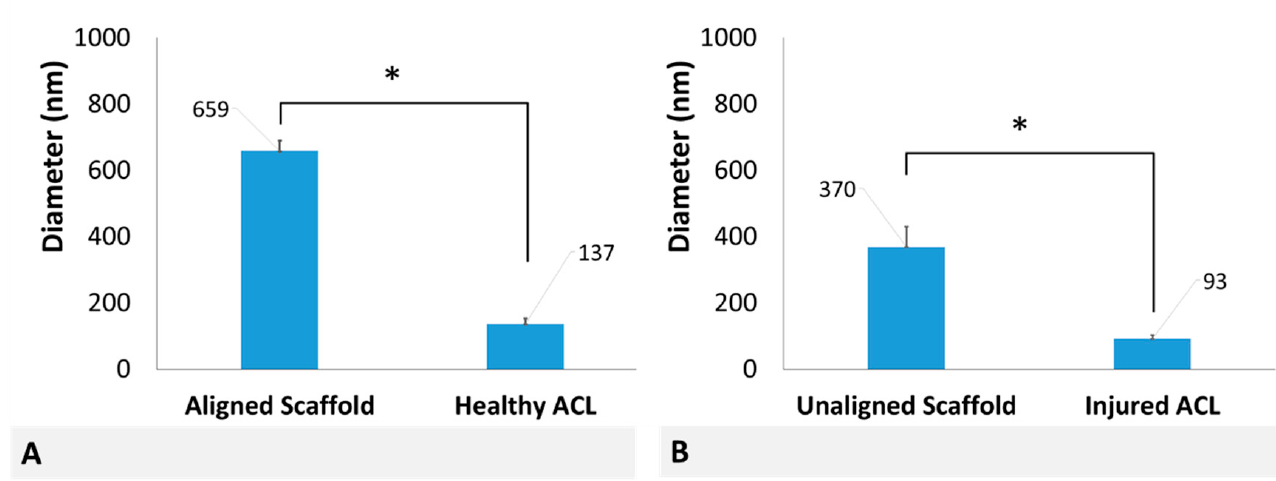
Figure 6. Comparison of mean diameters of ( A ) aligned scaffolds with healthy ACL and ( B ) unaligned scaffolds and injured ACL. * indicates statistically significant difference at p < 0.05 ( n = 3) and error bars represent SD.